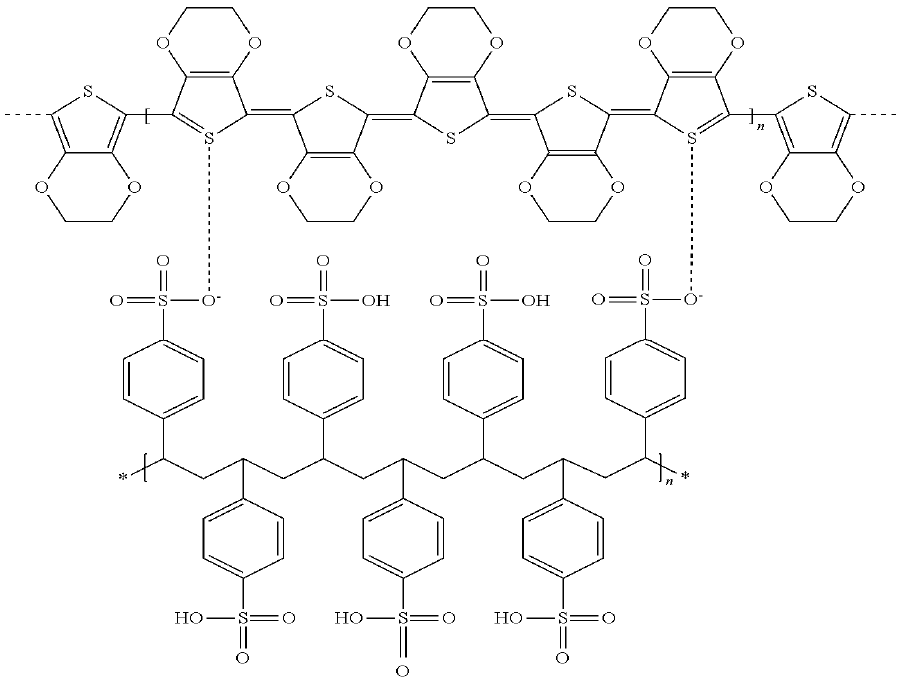
Figure 1. Structural scheme of PEDOT:PSS illustrating the interactions between ICP and counteranion (dopant anion) *: chain continuation.